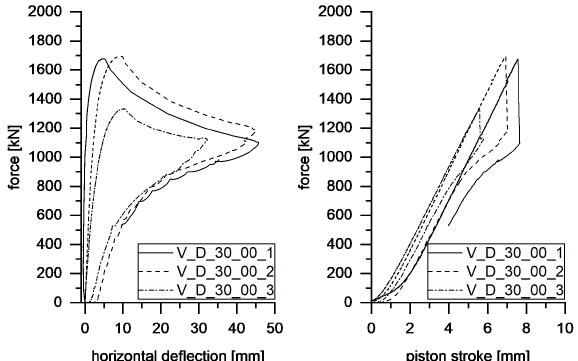
Figure 8. Force-horizontal deflection and force- piston stroke diagram for centrically loaded experi- ments [5].